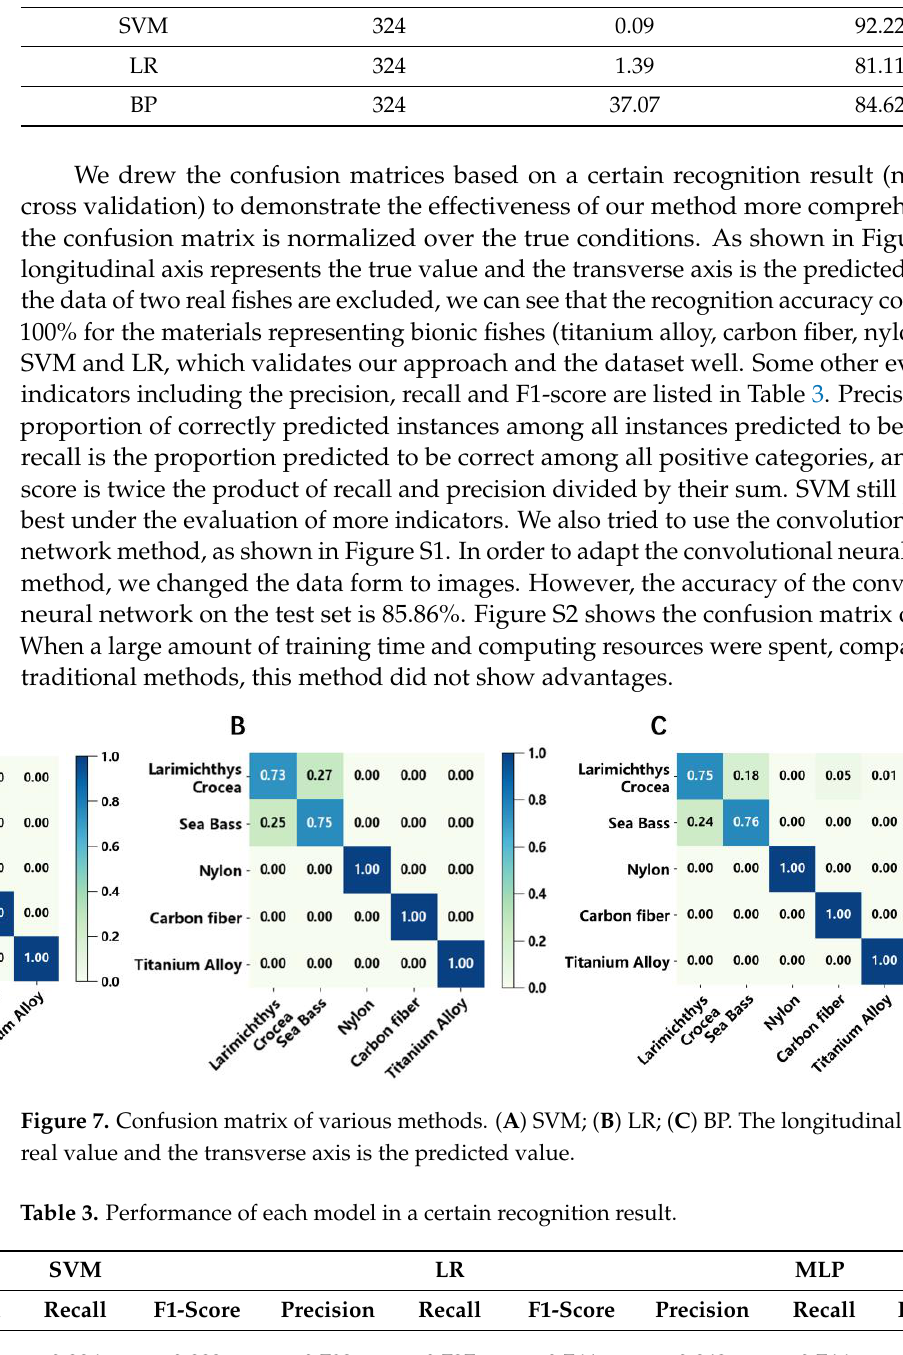
Table 2. Performance of each model in 5-fold cross validation.